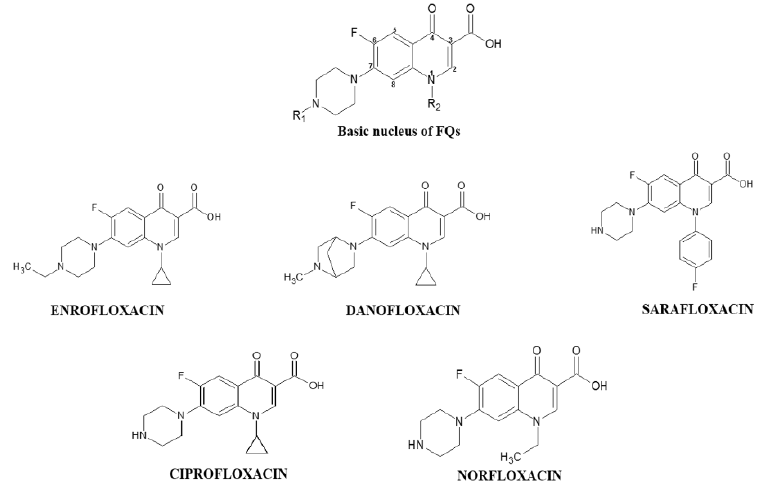
Figure 1. Chemical structure and basic nucleus of the fluoroquinolones (FQs) under study.